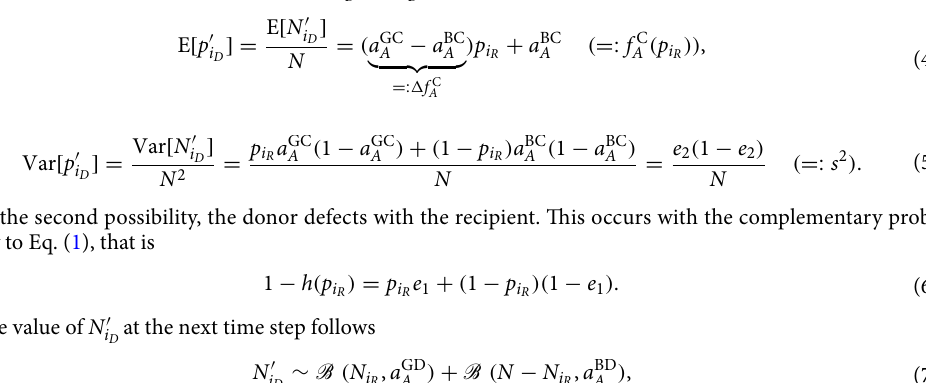
/ N are given by N ′ i D D =